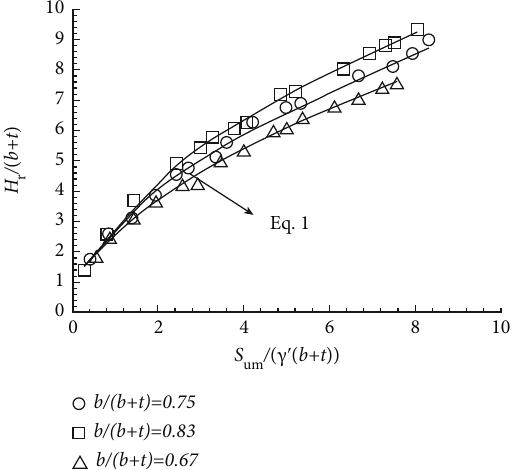
c ′ ( b + t )) � 0.42. (b) S um /(